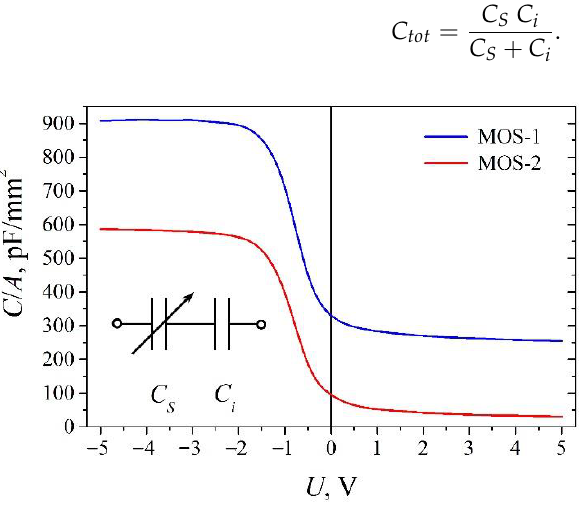
Figure 2. Capacitance of the MOS structures versus applied voltage. In inset: diagram of a MOS structure as a series circuit of two capacitors, variable C S and fixed C i .